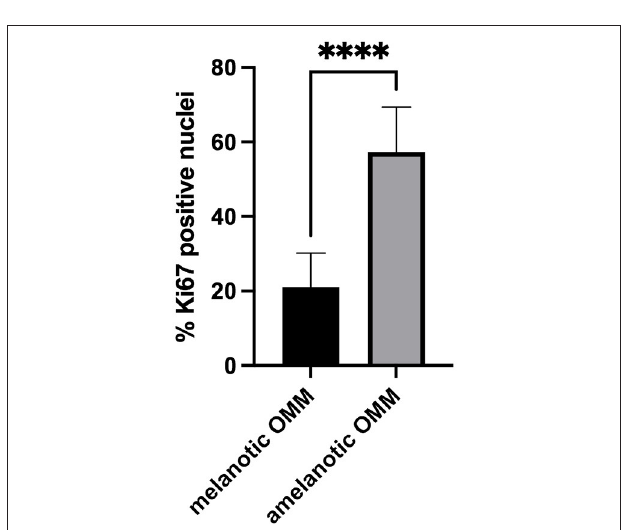
FIGURE 3 | Scores of the Ki67-positive nuclei in samples of canine melanotic and amelanotic OMM. Means were compared using the Student’s t -test. The percentage of Ki67-positive cells was significantly higher (****) in amelanotic OMM than melanotic OMM ( p < 0.05).